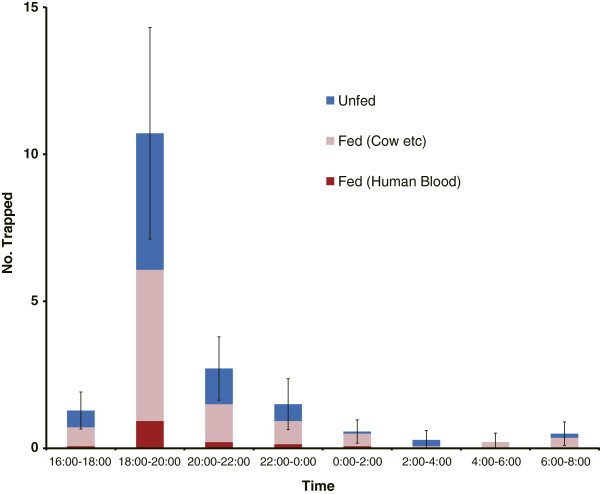
Indoor activity pattern of An. rivulorum females. Indoor activity pattern of An. rivulorum females trapped by Center for Disease Control miniature traps equipped with a collection bottle rotator. Bars indicate 95% confidential limits in total number of mosquitoes collected in each collection times.